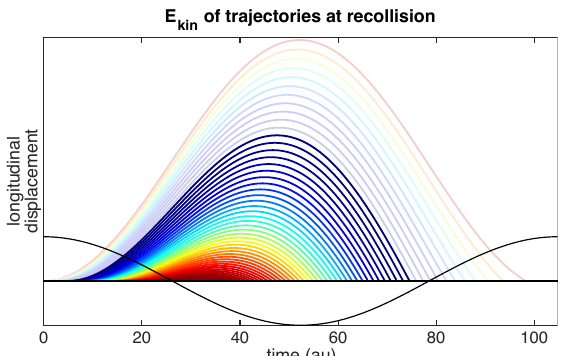
Figure 1. Photoelectron trajectories contributing to High Harmonic Generation (HHG). The colour code represents the kinetic energy of the trajectory at the return, where red is low and dark blue is high energy. Long trajectories are greyed out because typically the short trajectories dominate the spectrum. The black solid line represents the driving laser field − F x ( t )